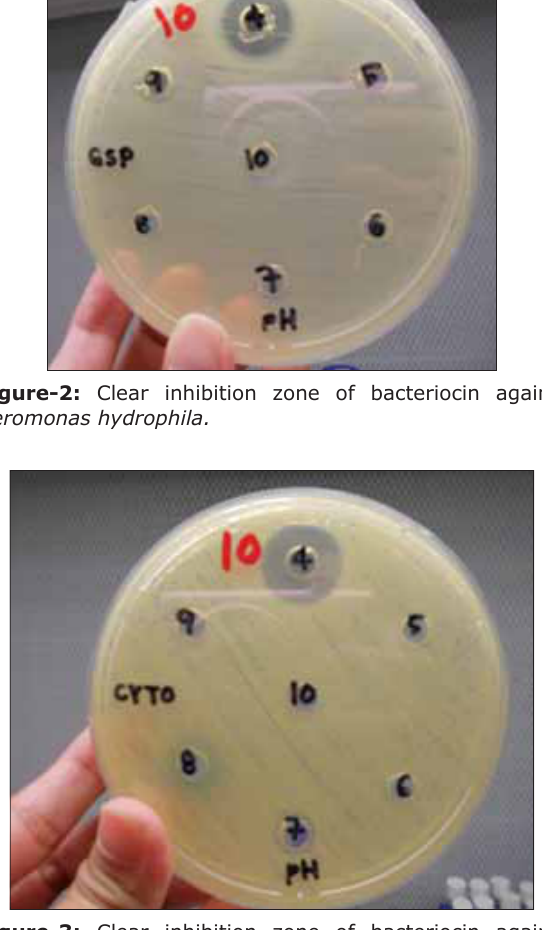
Table-1: MIC values of partially purified bacteriocin with 20% of ammonium sulfate and kanamycin against pathogenic bacteria from aquaculture sites.